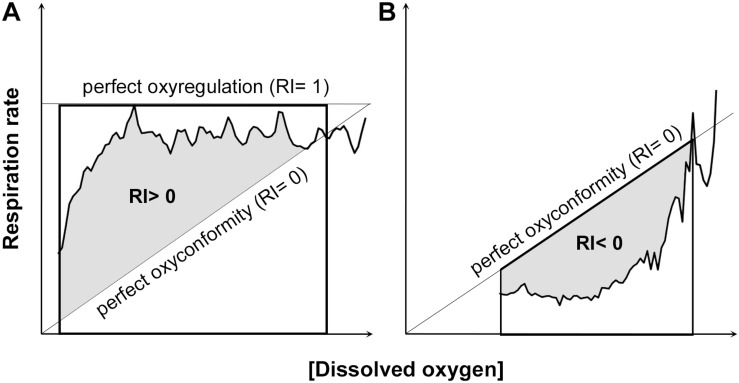
Examples of regulation index (RI) calculations. As shown by Mueller and Seymour (2011), the area under the curve and above the linear regression of perfect oxyconformity was used to calculate a positive RI (A). In contrast, a negative RI was calculated as the area bounded by the area above the curve and the linear regression of perfect oxyconformity (B).